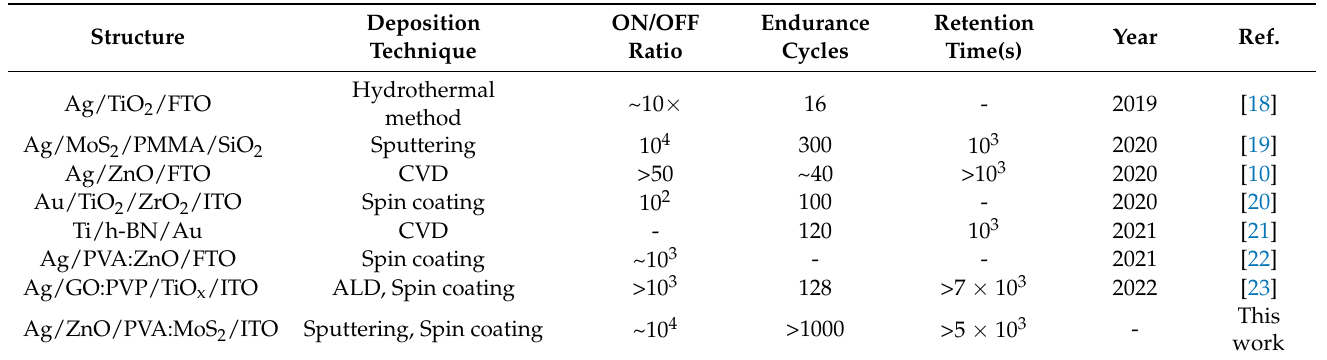
Table 1. Summary of some recent research on RRAM